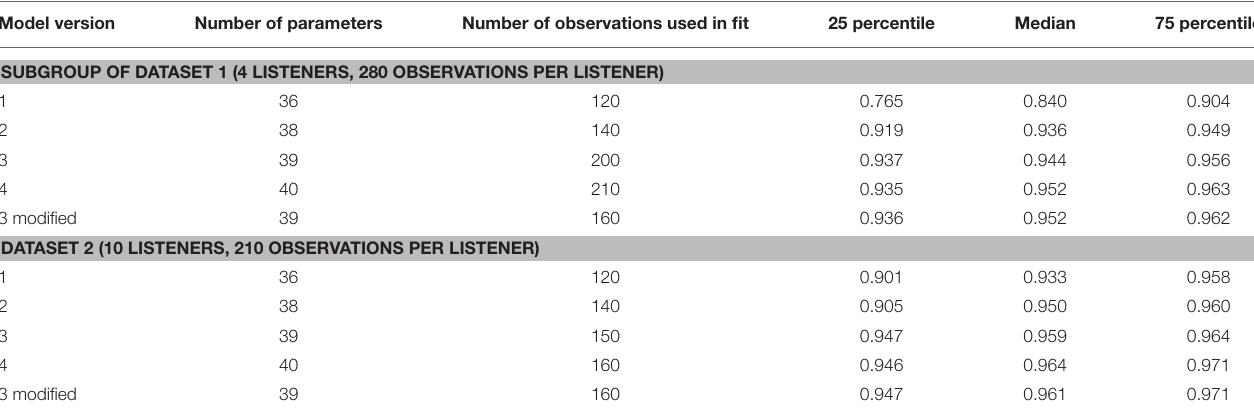
TABLE 3 | Adjusted ncc’ (Equation 10) across all